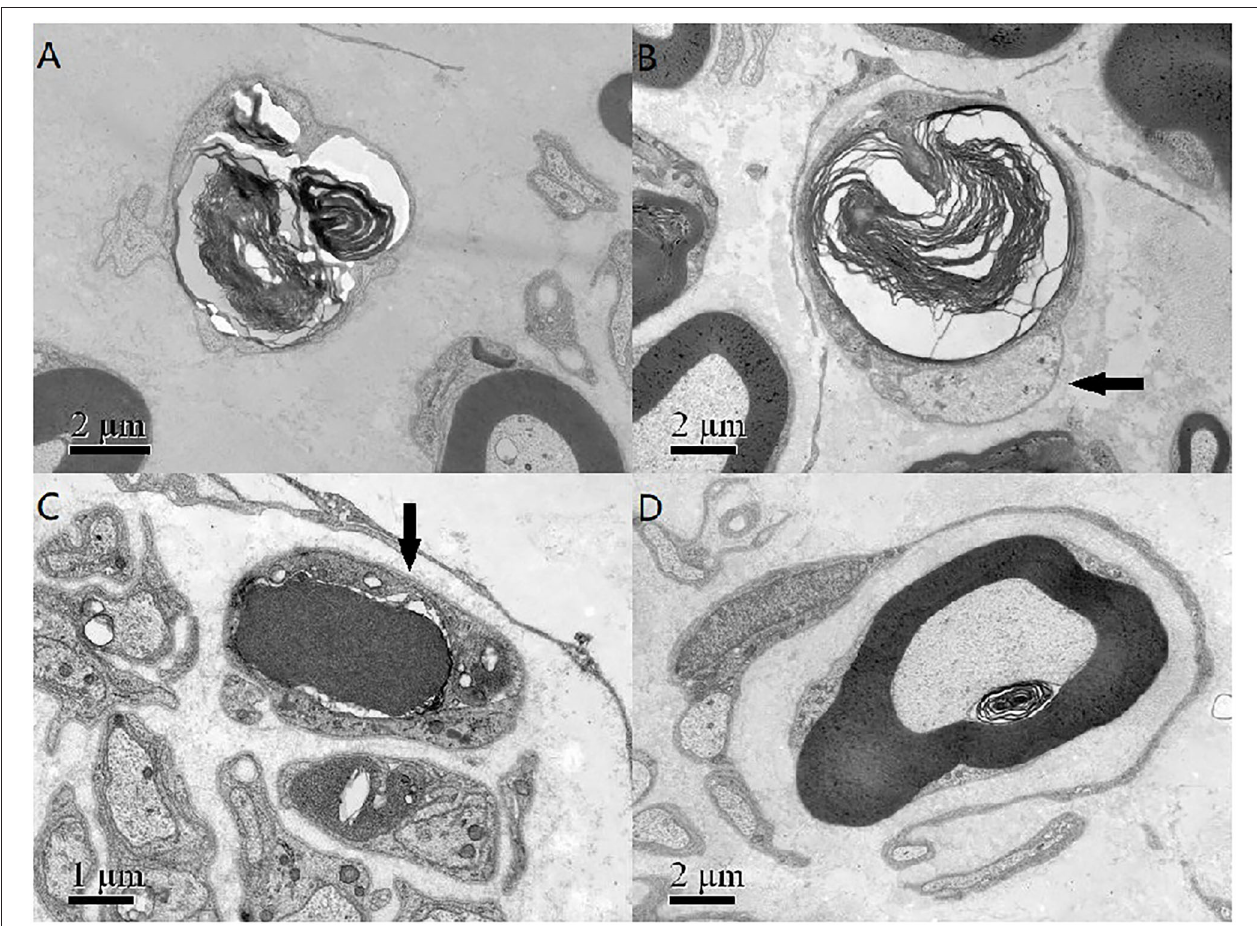
FIGURE 2 | (A) The axonal degeneration characterized by myelin remnants with irregular laminated structure within Schwann cells. (B) Myelin remnants with circular arrangement of myelin debris with an axon (arrow) surrounded by Schwann cell cytoplasm. (C) There was a non-membranous bounded osmiophilic dense crystalline-like inclusion bodies in a Schwann cell (arrow), and an osmiophilic inclusion with a fissure and organelle in another Schwann cells. (D) The Schwann cell processes and unmyelinated nerve fibers around a myelinated fibers formed an atypical onion bulb structure. Scale bar = 2 µ m in (A,B,D) . Scale bar = 1 µ m in (C)